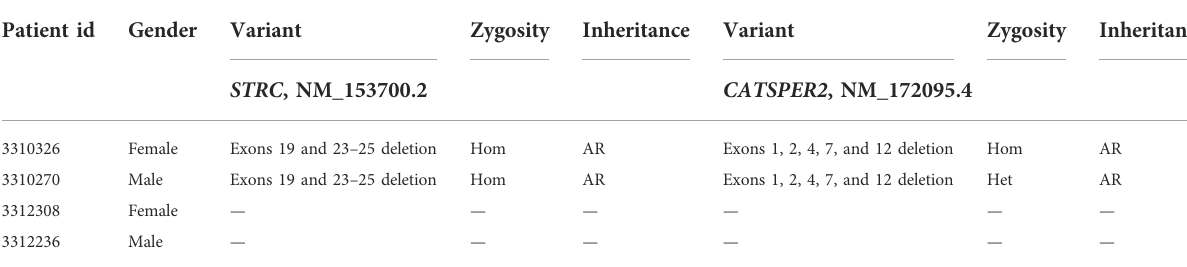
TABLE 4 Genotypic spectrum of four mild-to-moderate NSHL patients. Large CNV detection by